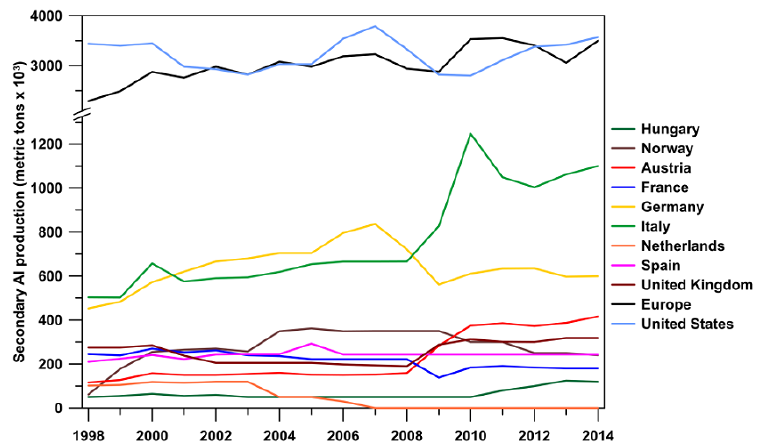
Figure 3. Secondary Al production from 1998 to 2014 in Europe and some European